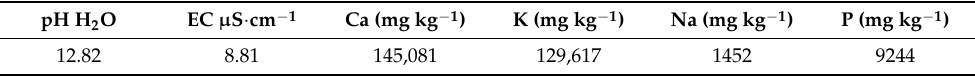
Table 2. Composition of biomass ash used in the experiment for fertilization of winter oilseed rape on podzolic